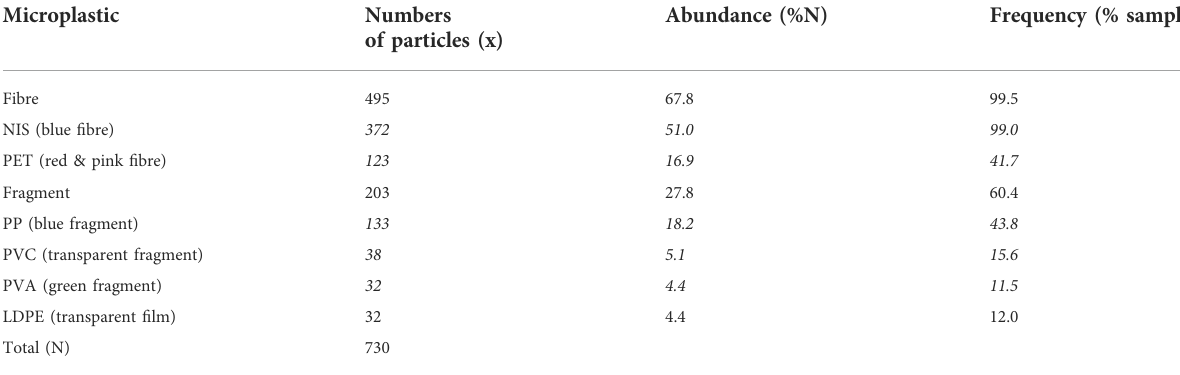
TABLE 2 Abundance and frequency of microplastics in the Pantanal wetland surface